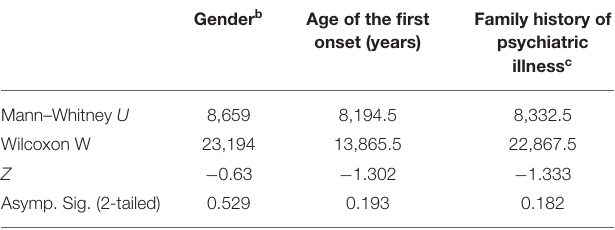
TABLE 1 | Comparisons of study sample and those lost to recruitment a . Gender